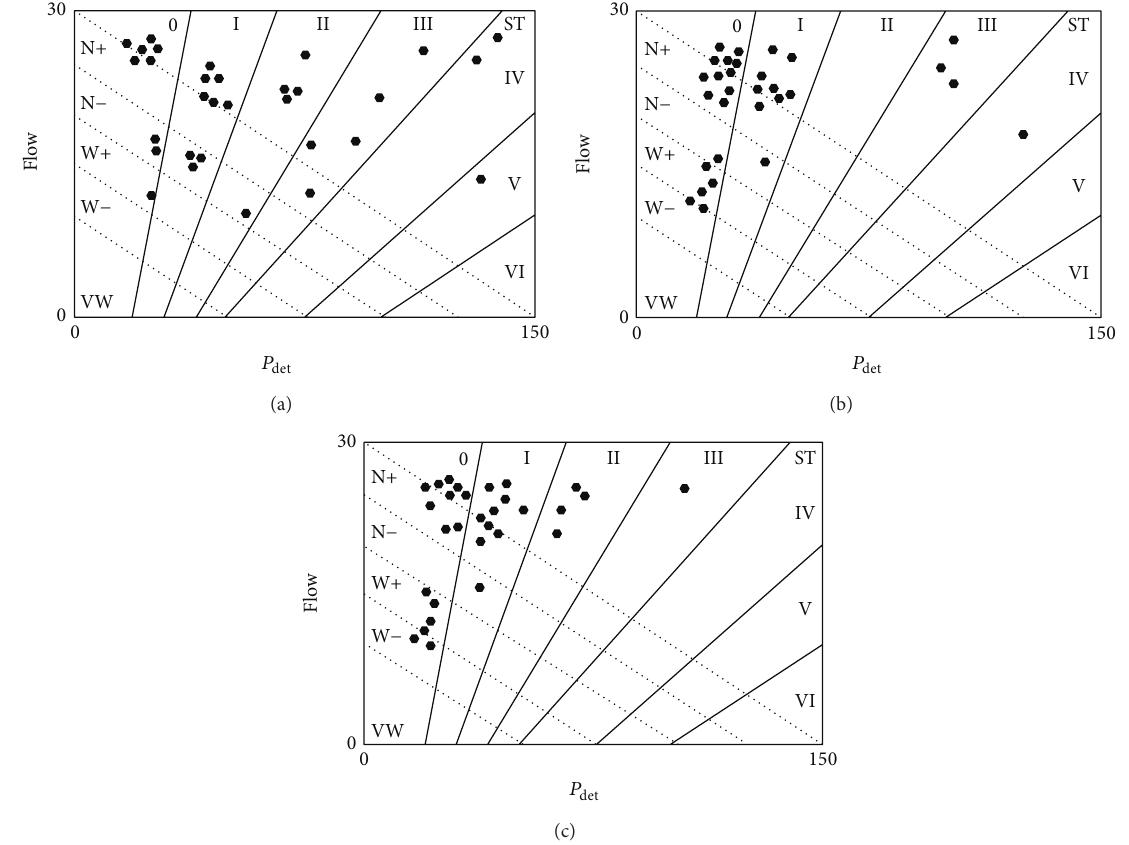
Figure 1: (a) Detrusor pressure at maximum detrusor pressure ( 𝑃 before HIFU. (b) Detrusor pressure at maximum detrusor pressure ( 𝑃 nomogram 3 months after HIFU. (c) Detrusor pressure at maximum detrusor pressure ( 𝑃 by the Schafer nomogram 6 months after